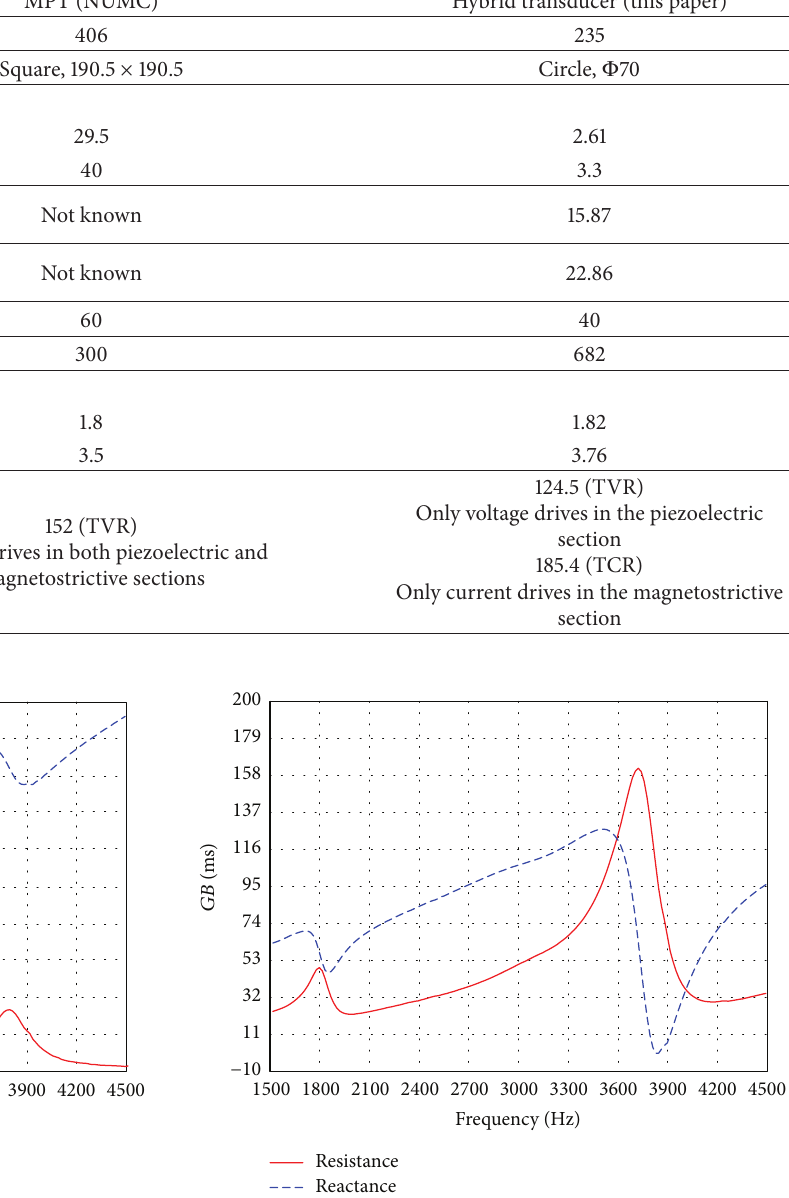
Figure 10: Impedance curves when only current drives in magne- tostrictive section (in water, obtained from Agilent